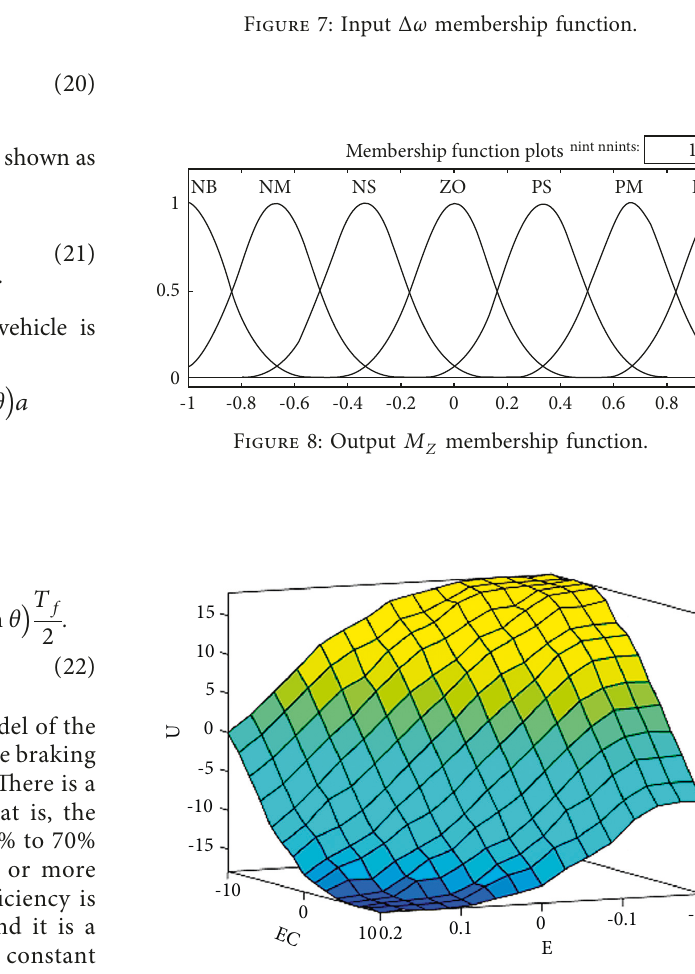
Figure 9: Fuzzy control diagram.